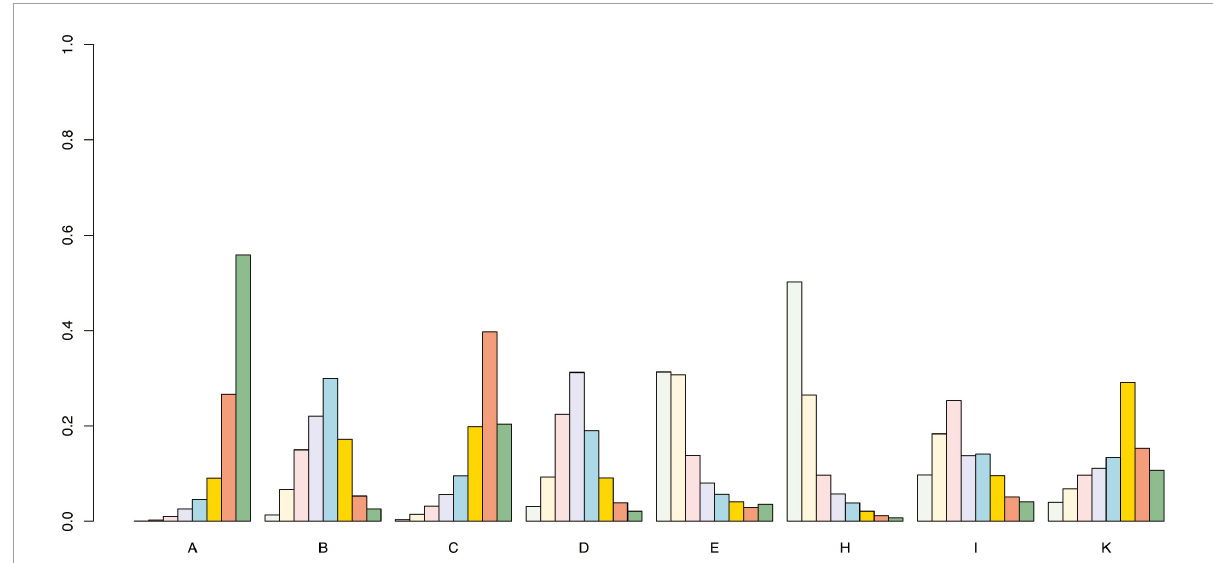
FIGURE7 Pittsburgh Sleep Quality Index probability ranking diagram. A = antiepileptics; B = manual acupuncture; C = electroacupuncture; D = fire needling; E = pricking and cupping; H = electroacupuncture plus antiepileptics; I = fire needling plus antiepileptics; K = acupoint catgut embedding plus